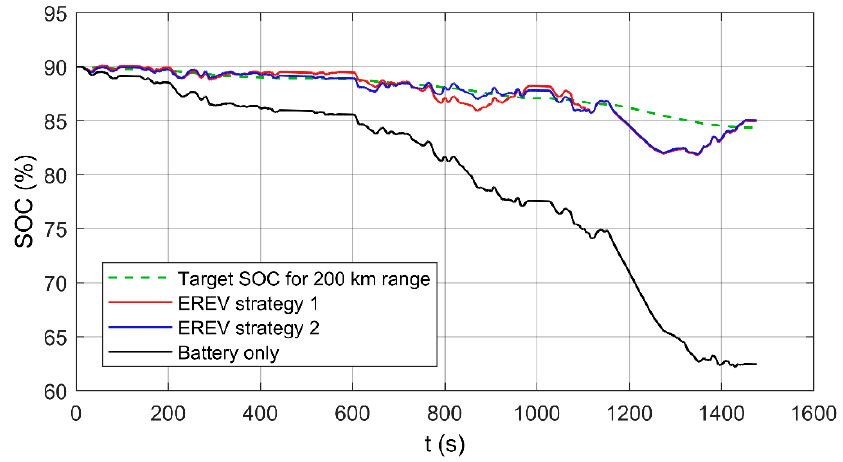
Figure 14. SOC changes in one simulated driving cycle for EREV operation for two range extender control strategies, along with their SOC target, and SOC changes for battery only drive.